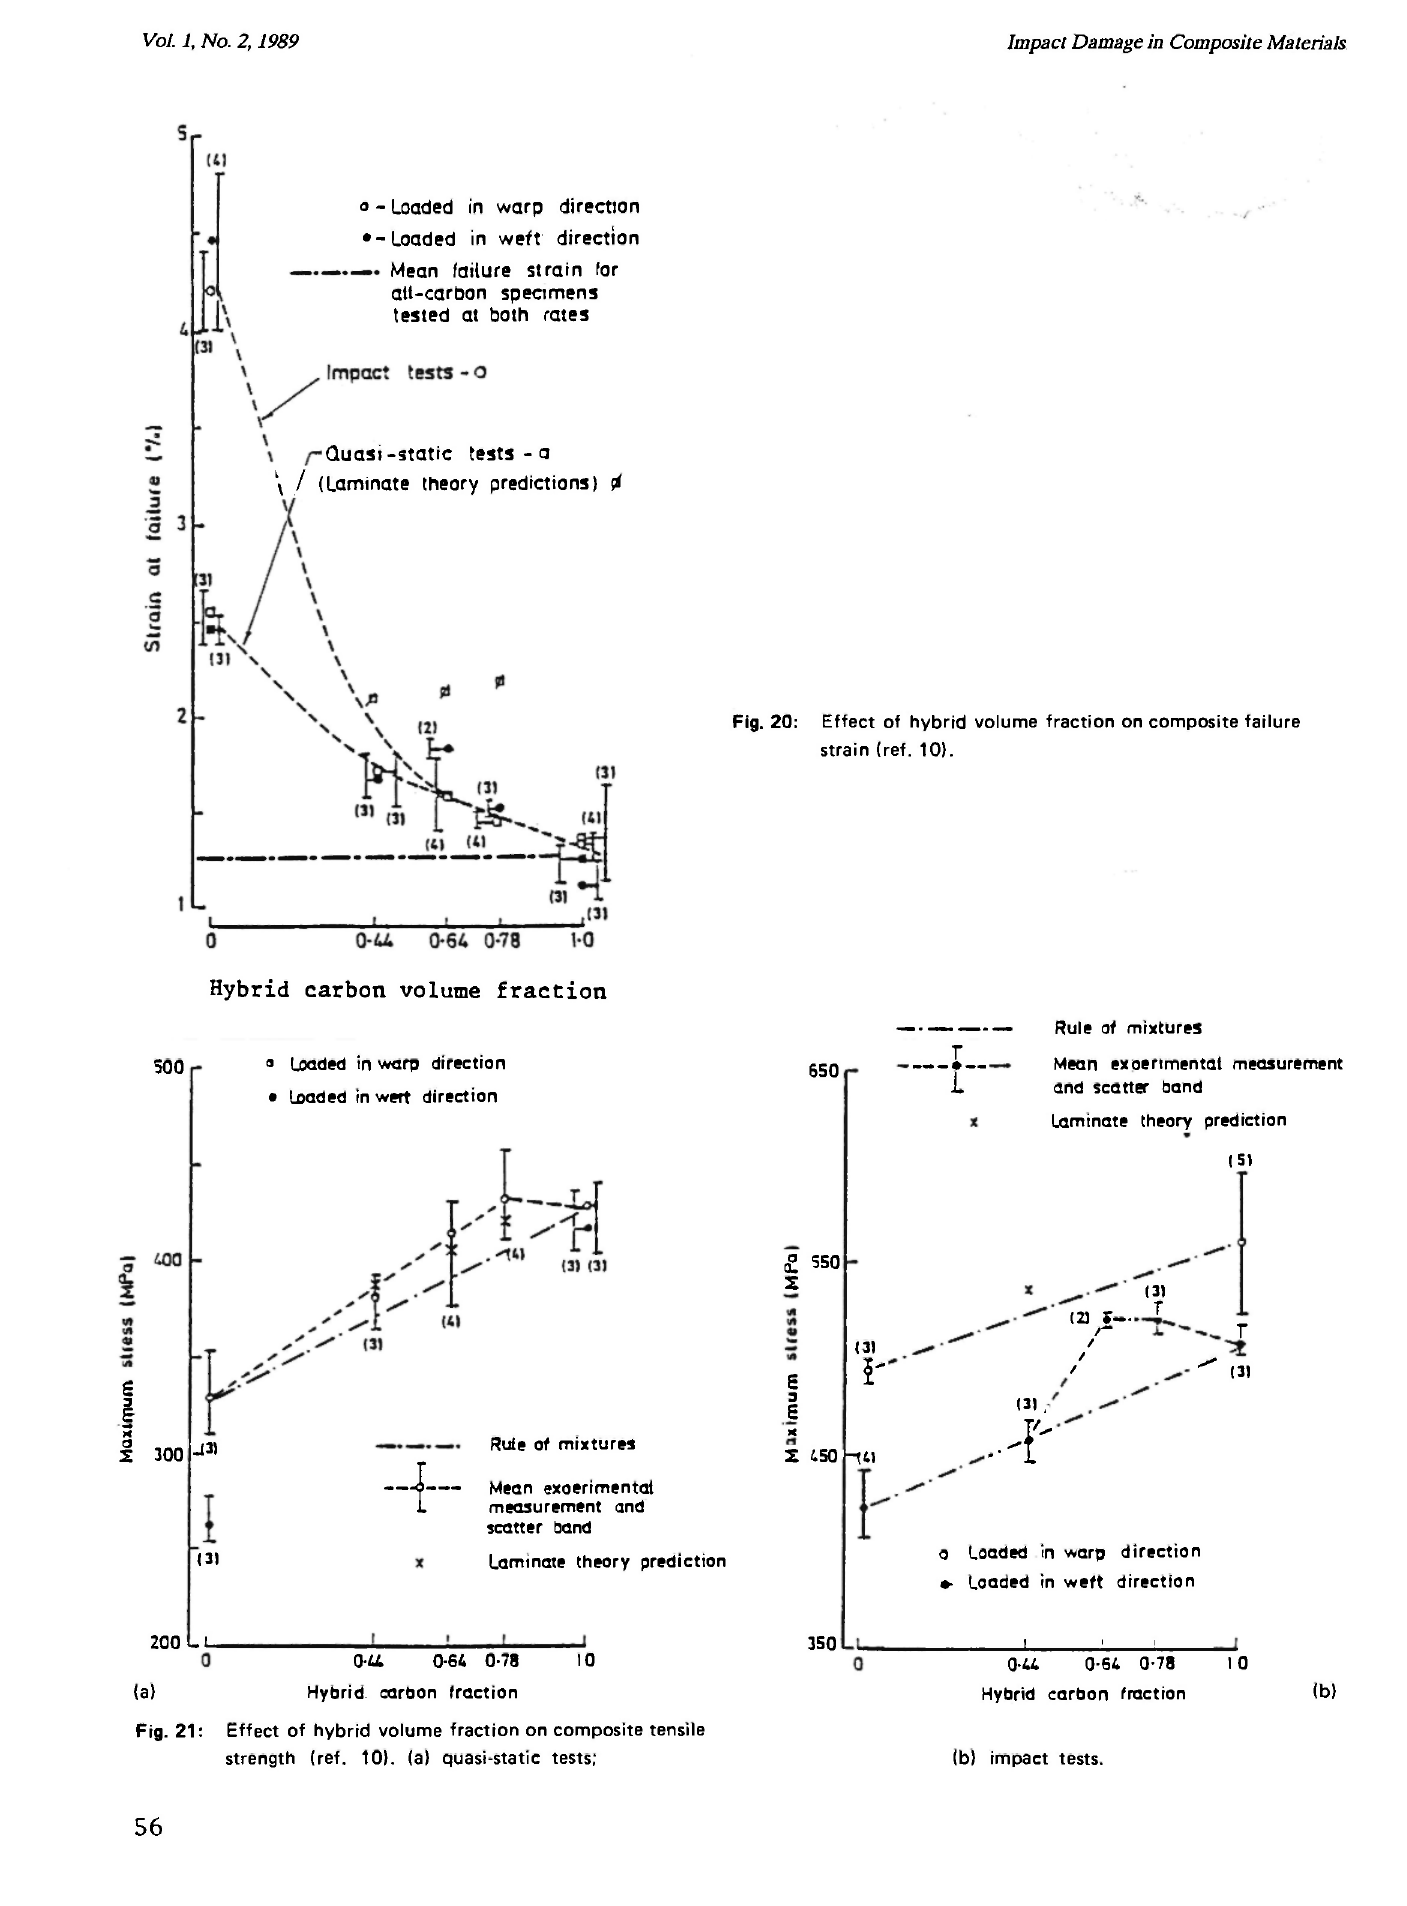
Fig. 21: Effect of hybrid volume fraction on composite tensile strength (ref. 10). (a) quasi-static